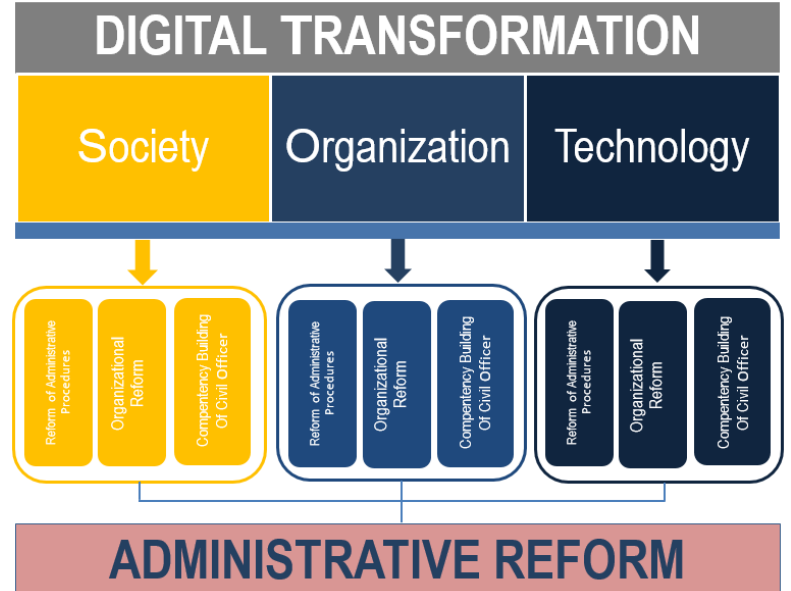
Figure 1. Flowchart of Research